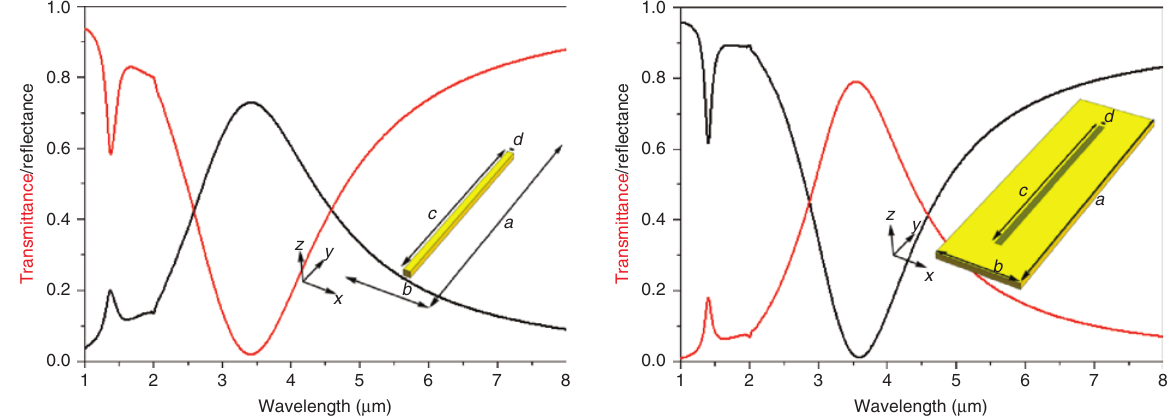
Figure 14: Comparison of the reflectance and transmittance spectra of an array of linear nanoantennas in free space with that of the inverse structure (an array of slits). For the nanoantennas, the polarization direction is parallel to the long axis, whereas for the slits, it is perpen- dicular to the slit.